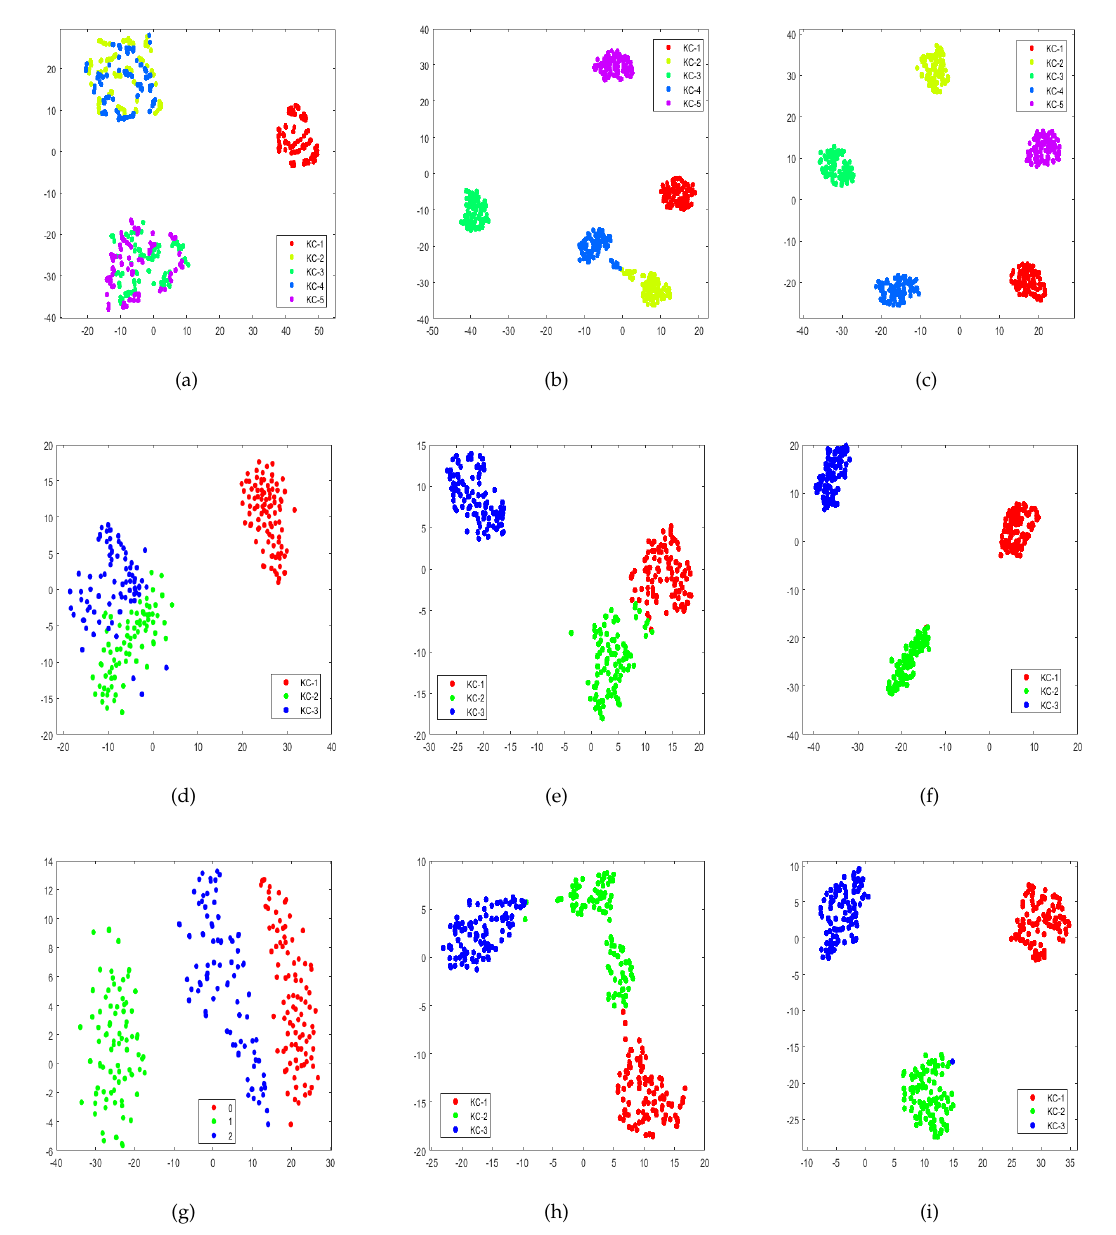
Figure 15. The t—SNE visualization compares three situations on a task of PHM09 ( a – c ); JNU (( d – f ); and SEU ( g – i